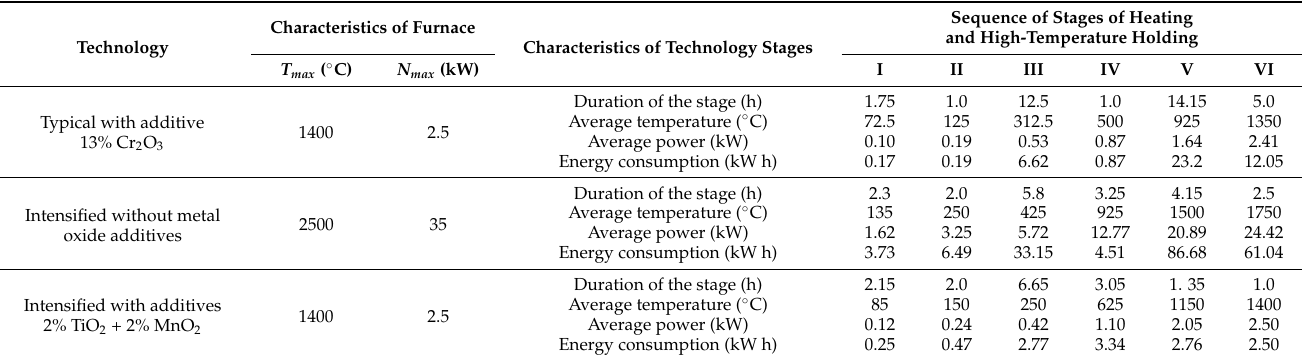
Table 4. Energy consumption in the thermal cycle of various manufacturing technologies of porous aluminum oxide ceramics in real conditions of experimental laboratory production.